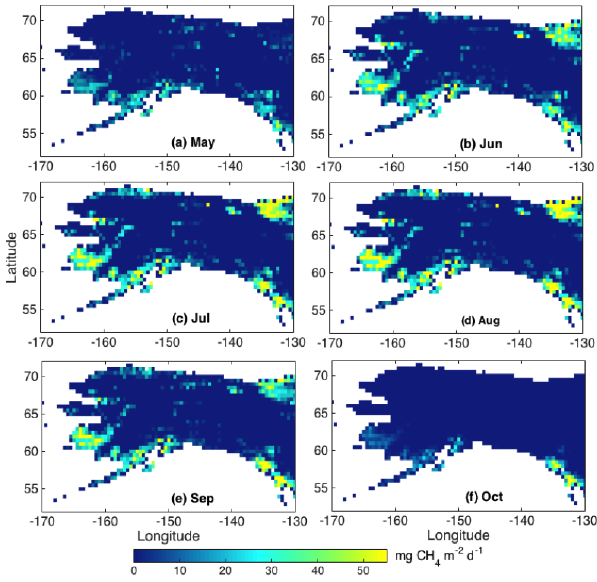
Figure 4. CLM4.5 simulated mean monthly CH 4 emissions with F def across years